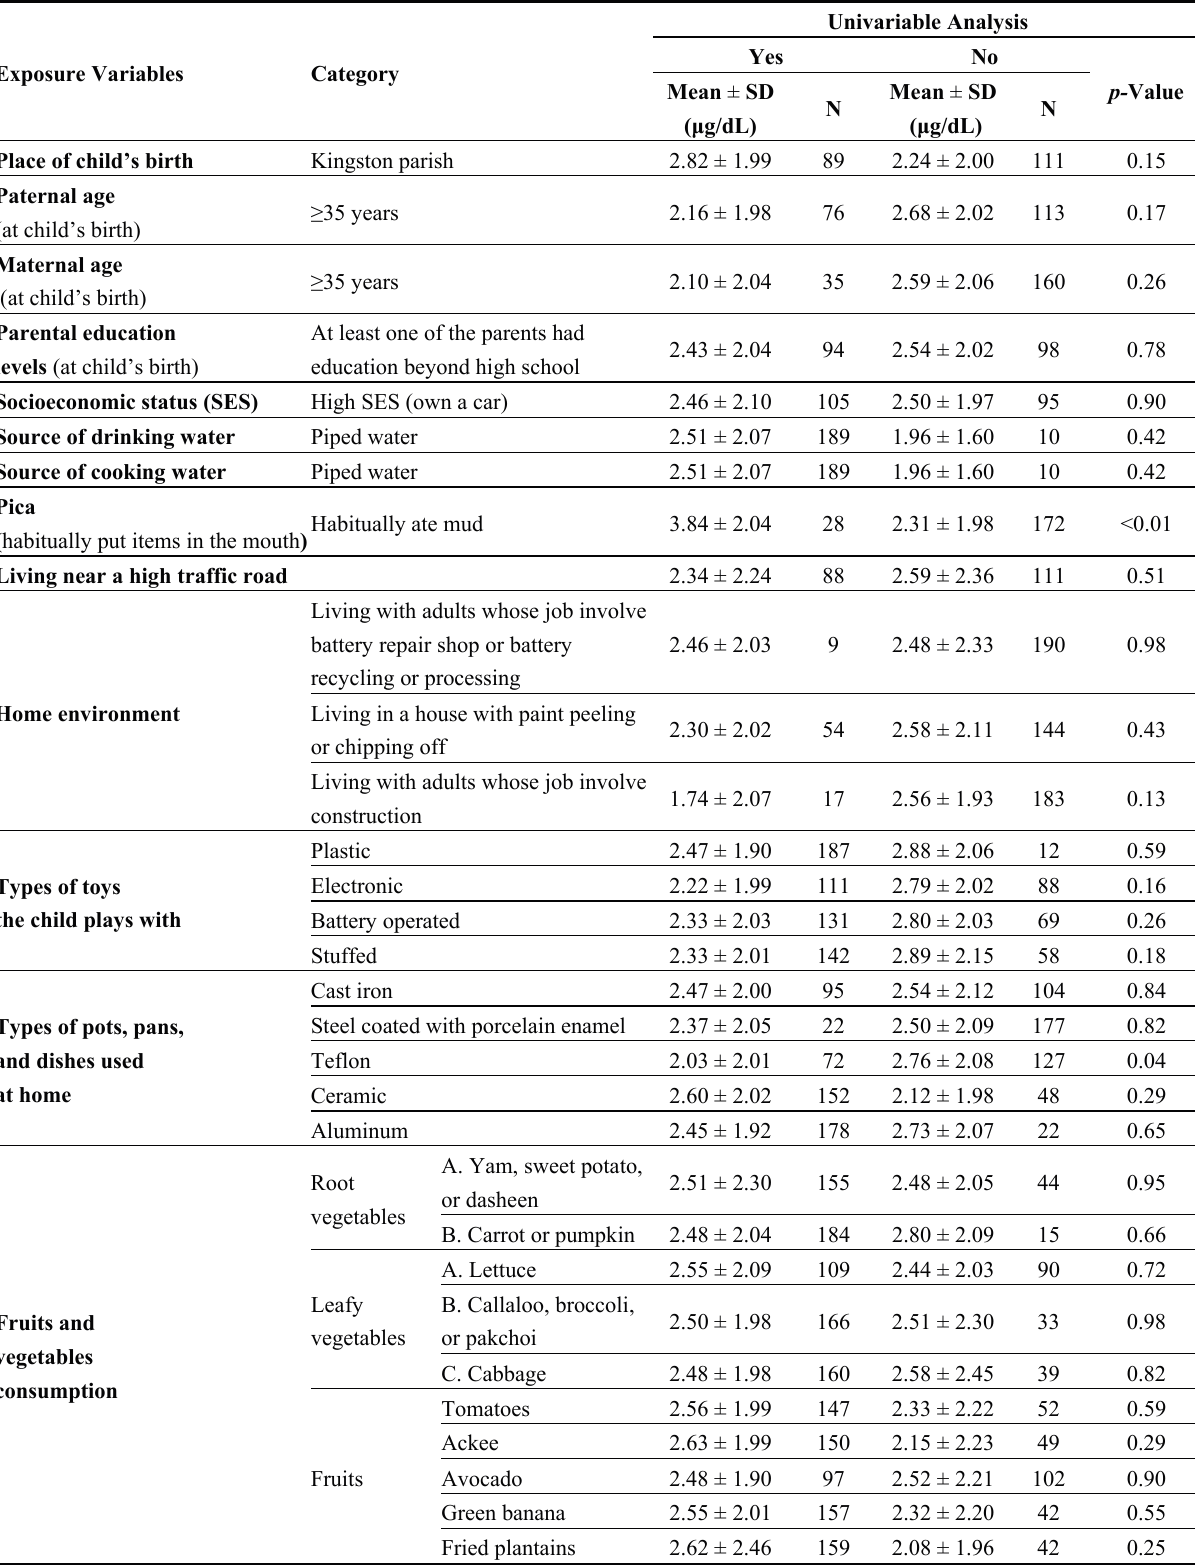
Table 3. Factors associated with blood lead concentrations based on univariable General Linear Models (100 matched pairs or 200